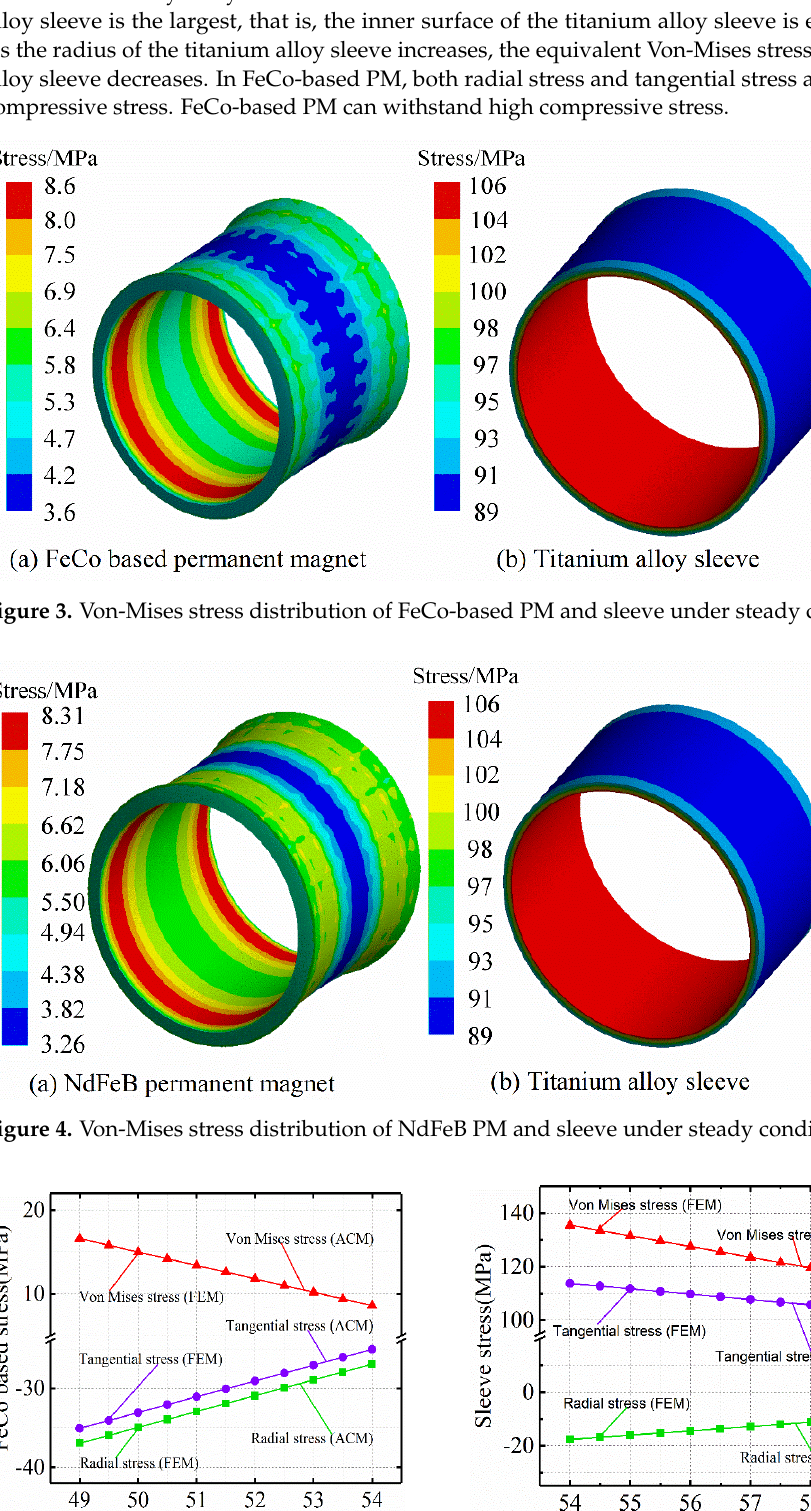
Figure 5. Stress distribution of ( a ) FeCo-based PM and ( b ) sleeve under steady condition.